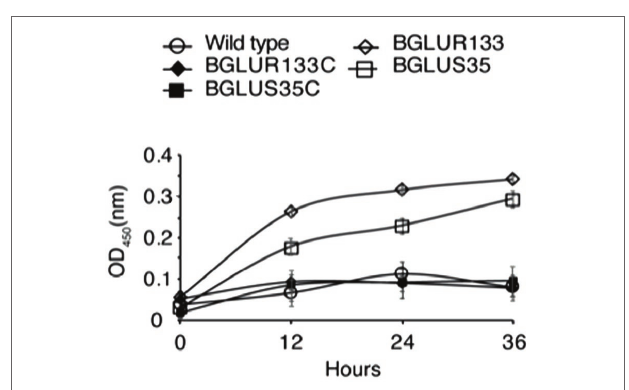
FIGURE 3 | The role of GluS-GluR in the expression of β -lactamases. β -lactamase activity was measured in LB medium according to nitrocefin substrate hydrolysis, and relative amounts of β -lactamase produced by each strain quantified at OD 450 at the indicated times. Data are mean ± SE of triplicate experiments. PBS, phosphate-buffered saline (pH